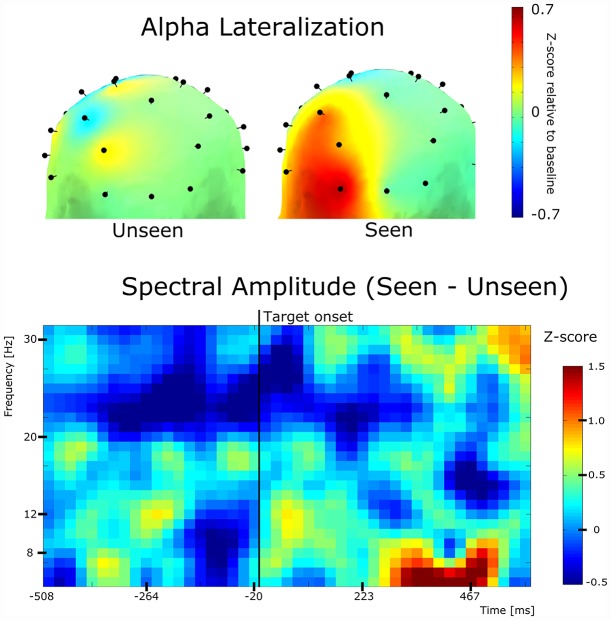
Lateralization distribution and general spectral differences.(Top) Half-scalp topoplots depicting the magnitude of lateralization for Seen and Unseen conditions. All of the data is presented on the left side of the scalp images (chosen arbitrarily, see Methods). It shows the topological distribution of alpha lateralization across parieto-occipital locations. (Bottom) Time-frequency plot of the differences in spectral amplitudes between Seen and Unseen conditions. Time cero corresponds to the beginning of target presentation.